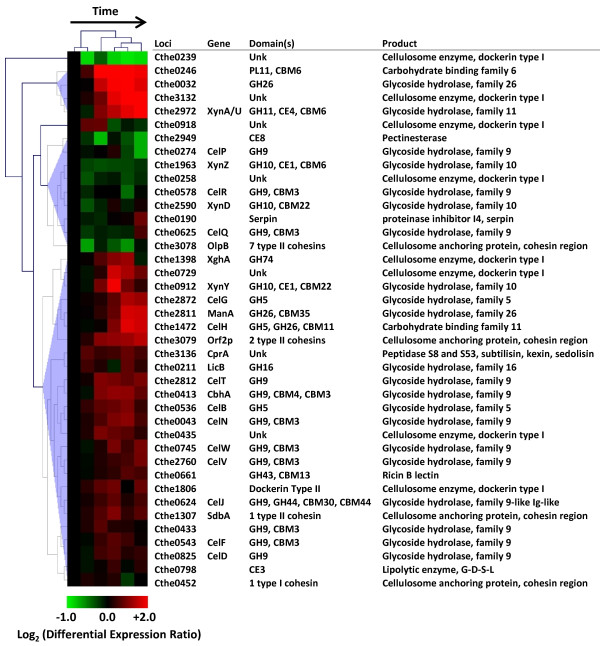
Cellulosomal genes differentially expressed during cellulose fermentation. Heat plot representation of Log2 (Differential Expression Ratio) and hierarchical clustering of cellulosomal genes showing statistically significant differences in transcript expression over the course of Avicel® fermentation by Clostridium thermocellum ATCC 27405. Domain key: GH = Glycoside Hydrolase, CE = Carbohydrate Esterase, PL = Polysaccharide Lyase, CBM = Carbohydrate Binding Module, Unk = unknown, based on the Carbohydrate Active Enzymes database (http://www.cazy.org; [41])